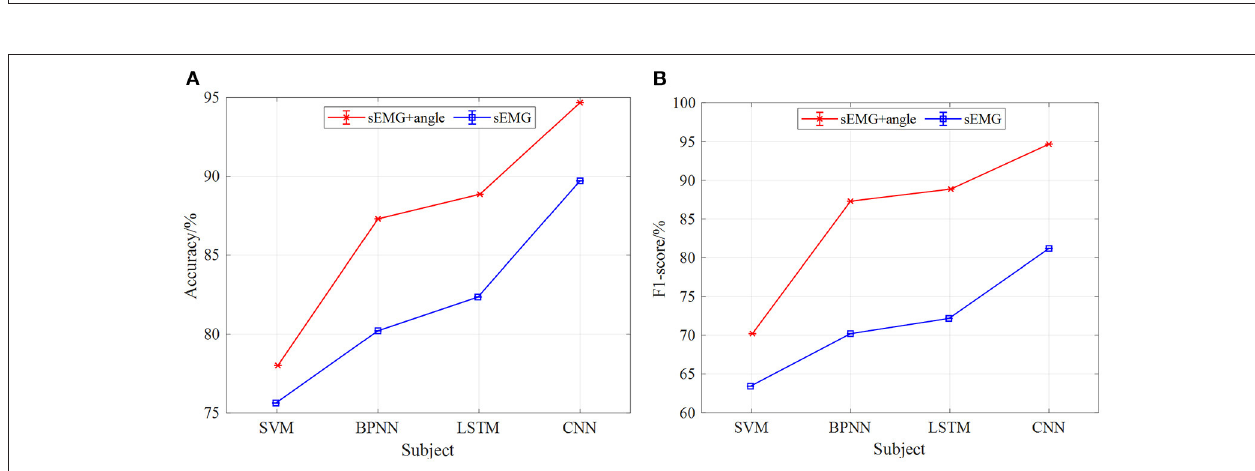
FIGURE 12 | The accuracy confusion matrix of different gait speeds of the CNN model at the 5-fold cross-validation method, (A) a confusion matrix of 1km/h, (B) a confusion matrix of 2km/h, (C) a confusion matrix of 3km/h.